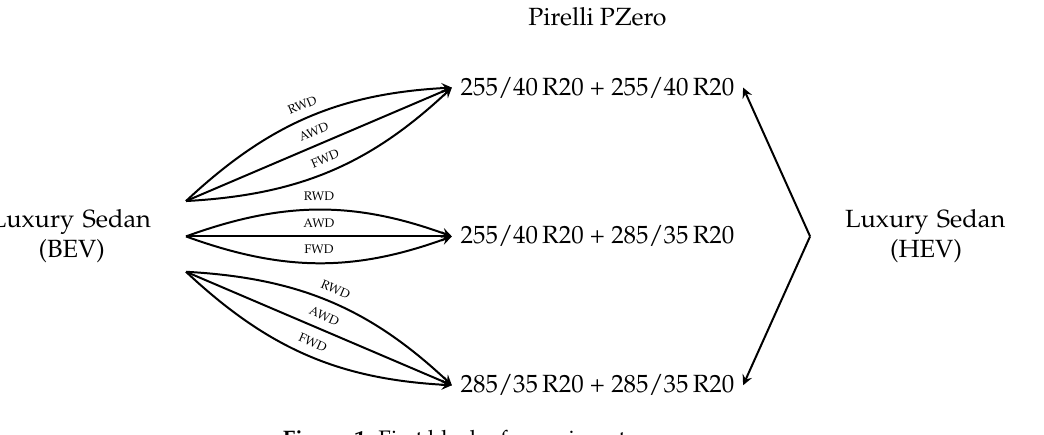
Figure 1. First block of experiments.